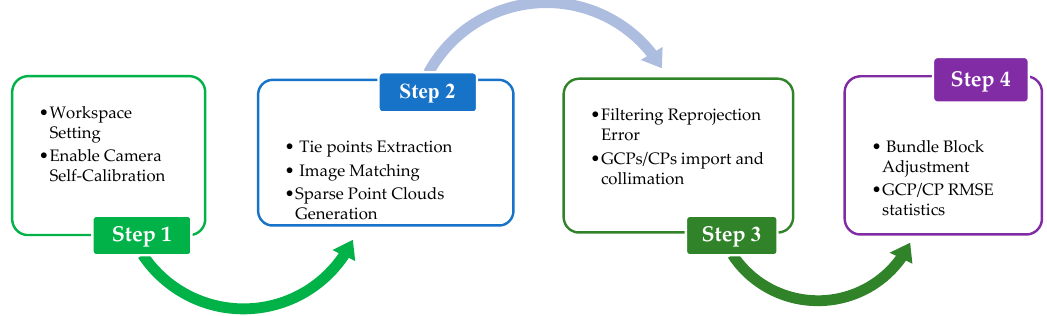
Figure 2. General steps of a photogrammetric process workflow [34]. First step: setting the working environment. Second step: initiating photogrammetric processes using structure from motion techniques. Third step: procedures for refining the obtained models. Fourth step: model verification and validation.